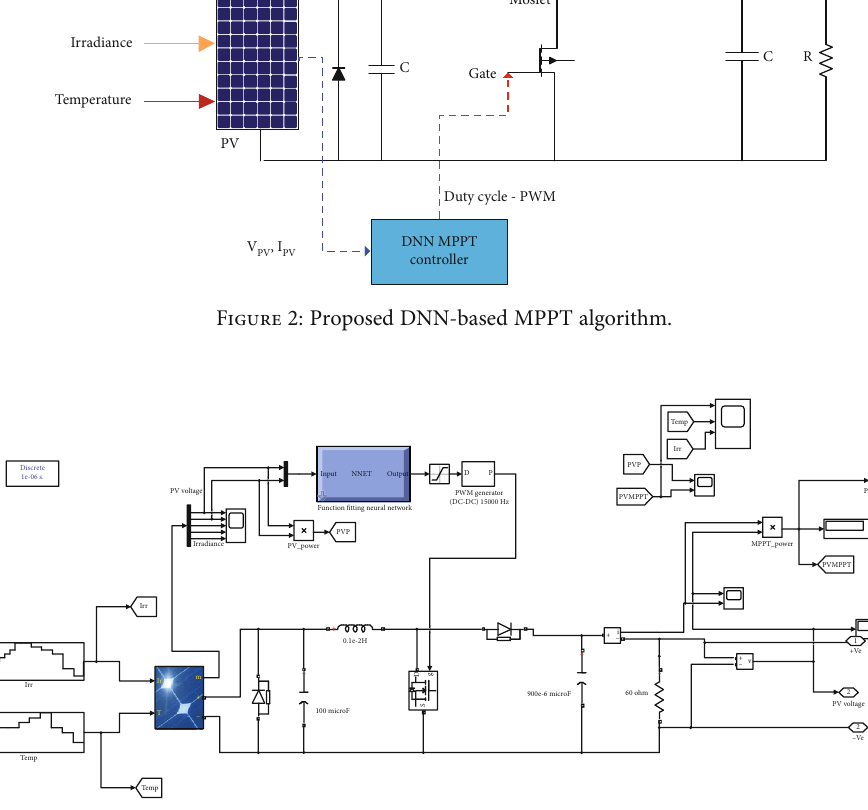
Figure 3: Simulation model of DNN controller-based MPPT algorithm for the PV